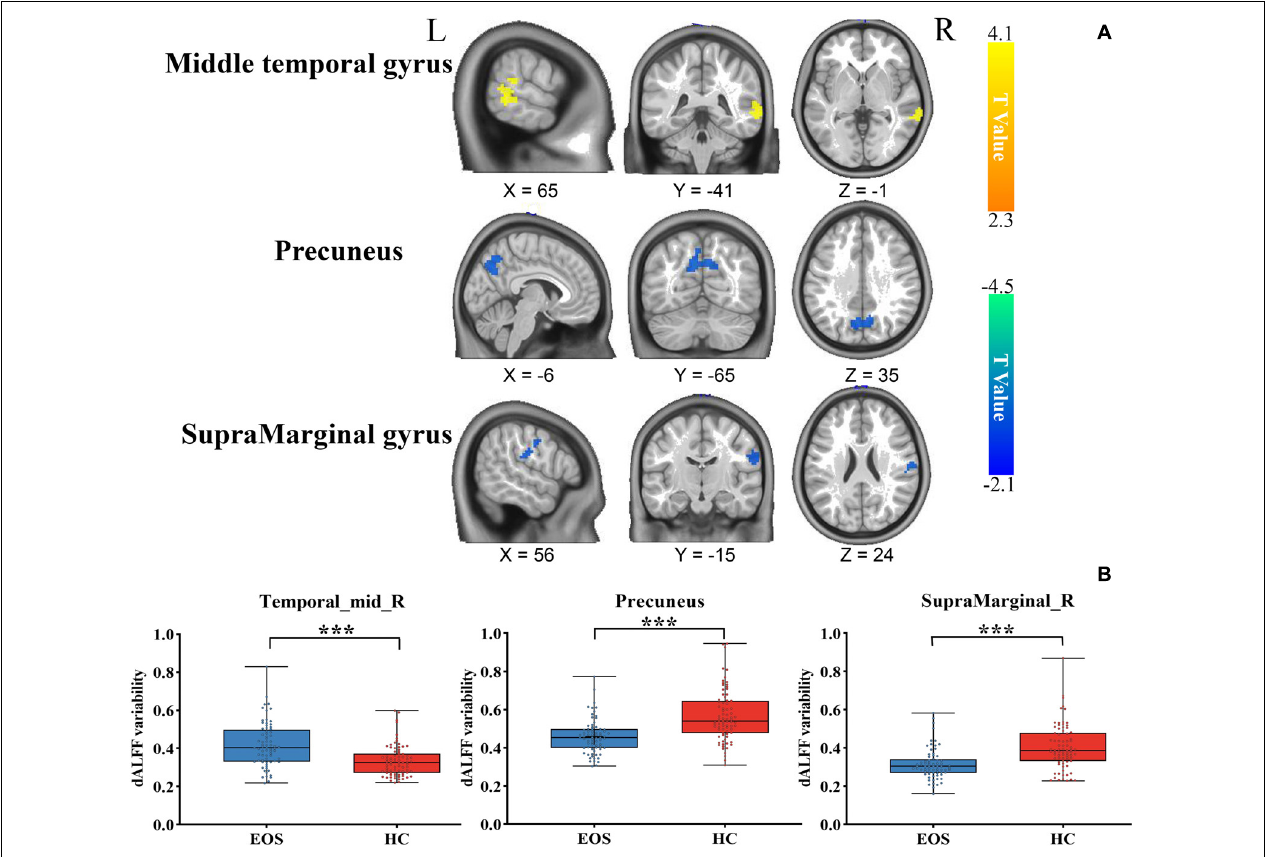
FIGURE 2 | Brain region differences in dALFF variability in EOS compared to HCs. (A) EOS showed increased dALFF variability in the right middle temporal gyrus (MTG) (winter color) and decreased dALFF variability in the bilateral precuneus, right supramarginal gyrus and post-central gyrus compared to HCs (warm color) ( GRF corrected; p < 0.005; cluster level, p < 0.05; minimum clusters size of 20 voxels). (B) The graph exhibiting the ROI-wise post hoc comparison results. * p < 0.01, uncorrected; *** p < 0.0001, Bonferroni correction.